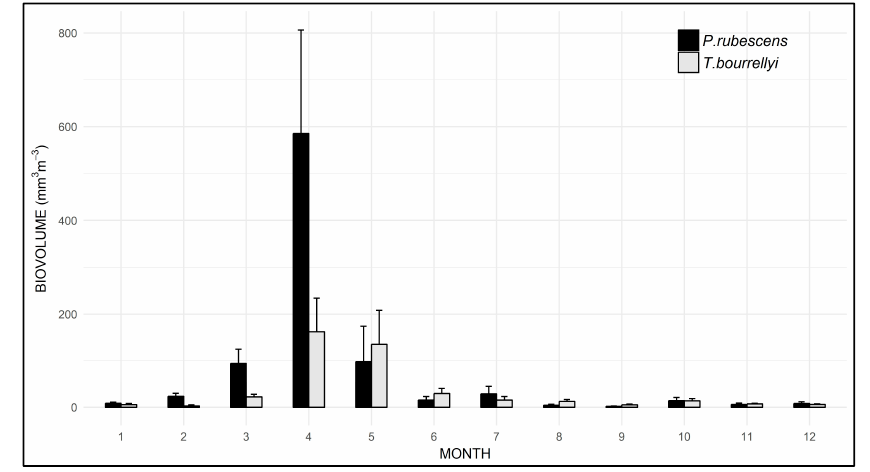
Figure 4. Monthly mean biovolume ± SEM (mm 3 /m 3 ) of P. rubescens and T. bourrellyi in 2016.